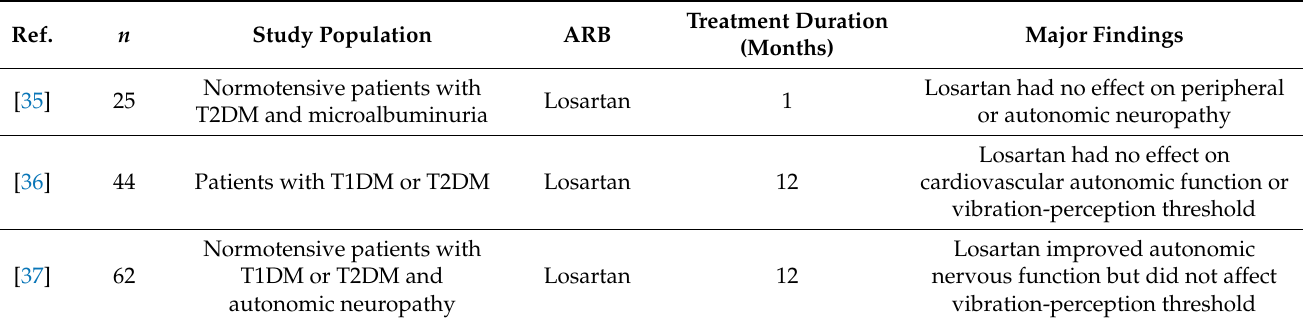
Table 2. Principal findings of major clinical studies that evaluated the effect of angiotensin receptor blockers (ARBs) on diabetic